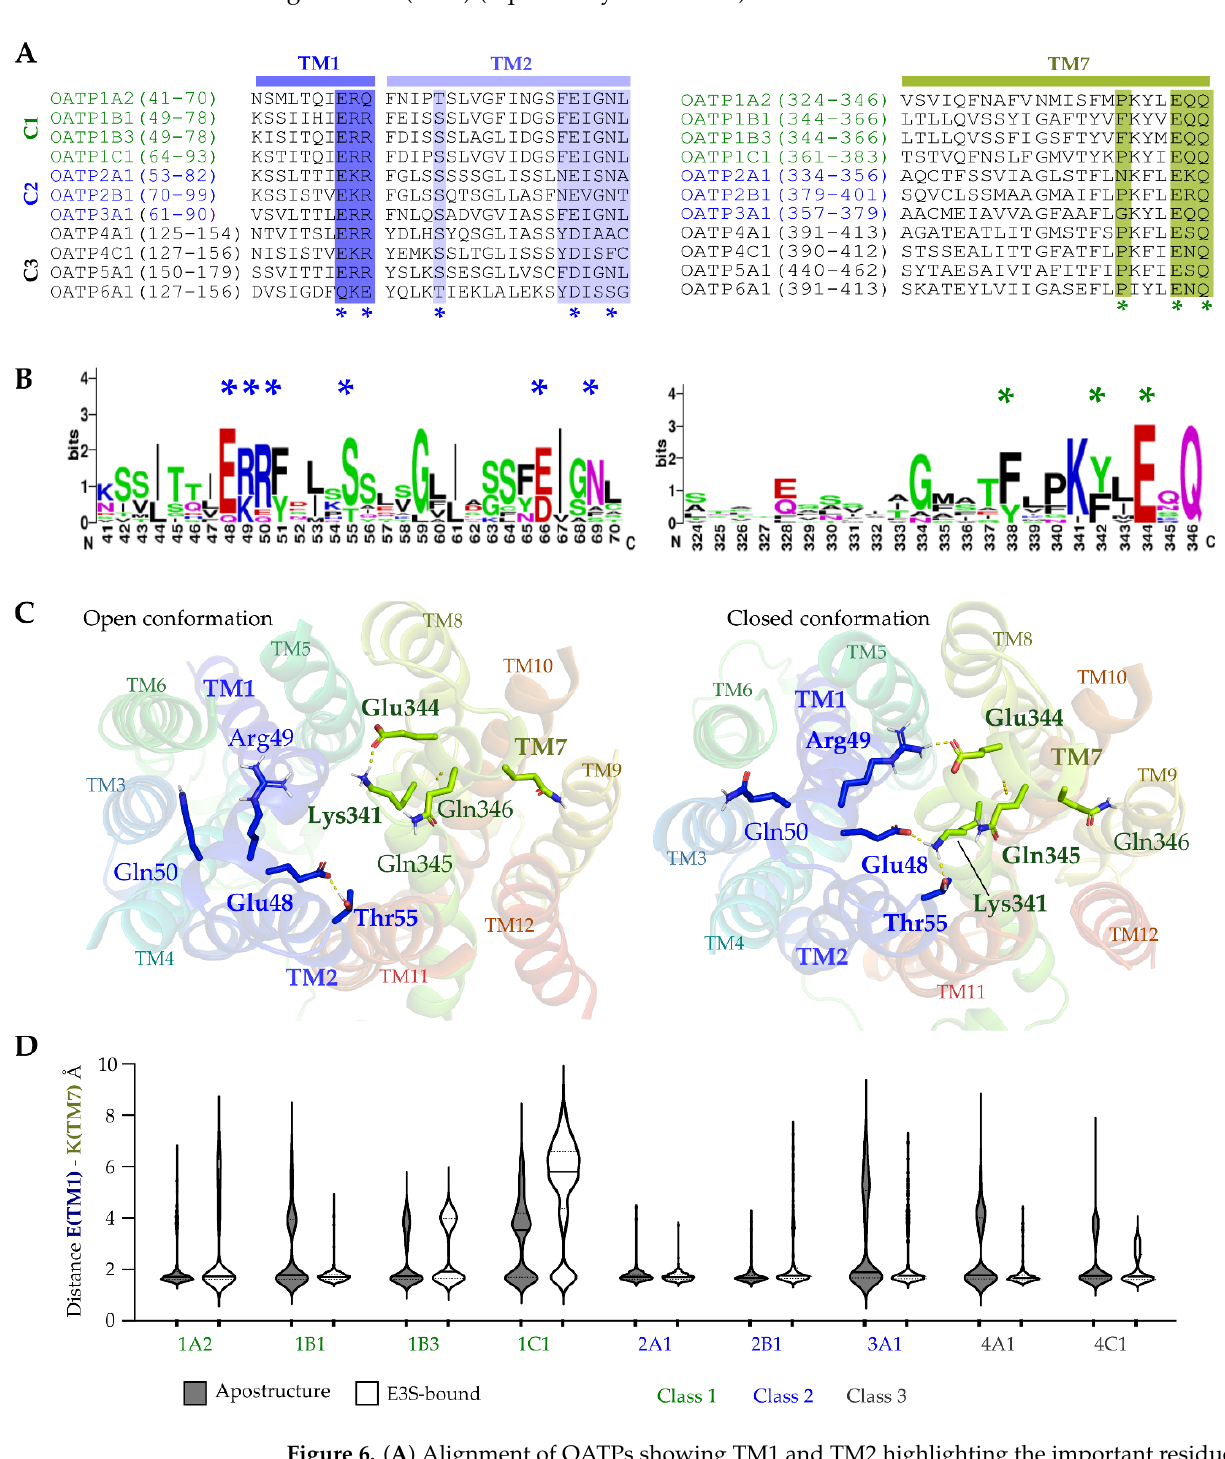
Figure 6. ( A ) Alignment of OATPs showing TM1 and TM2 highlighting the important residues in blue (left) and TM7 (right) with residues involved in the interactions with TM1 displayed in green. ( B ) HMM-Logos showing the conservation of highlighted residues. ( C ) Salt bridges involved in the opening (left) and closing (right) of the entrance of the transporter (displayed on the OATP1A2). ( D ) Distance between Glutamate on TM1 and Lysine on TM7 observed in the molecular dynamics simulations. Conserved amino acids are indicated with * in A and B.